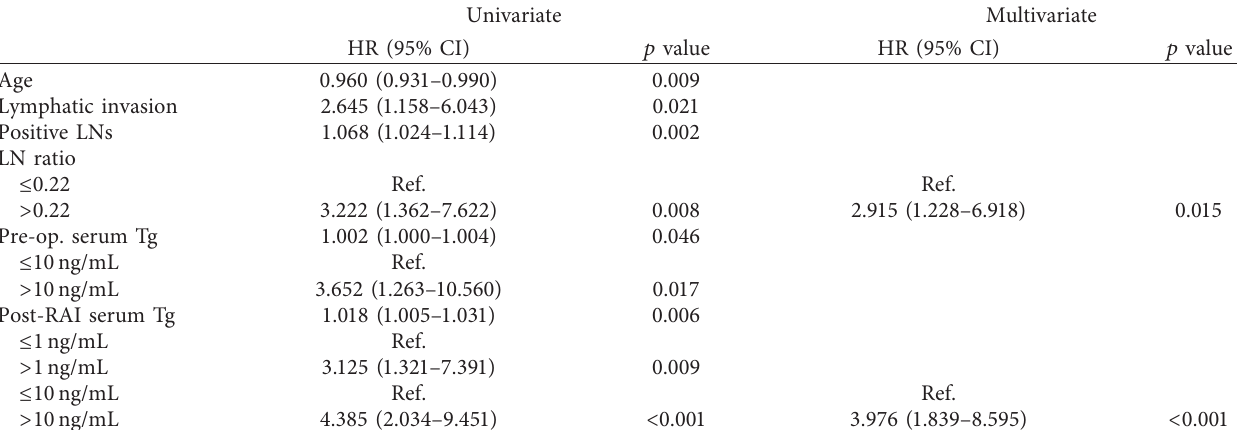
Table 4: Univariate and multivariate analyses of recurrence risk factors after propensity score matching. Univariate Multivariate